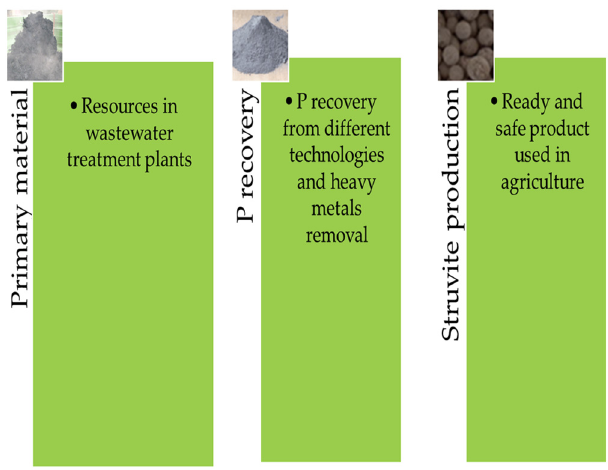
Figure 1. General diagram of struvite production.